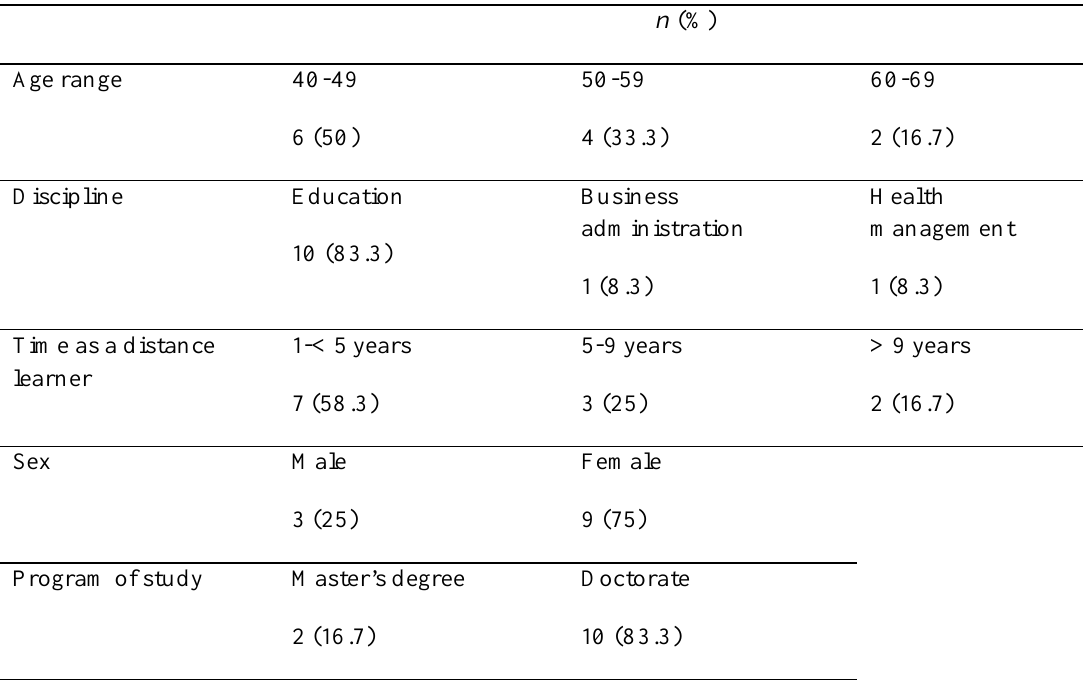
Demographic Characteristics of